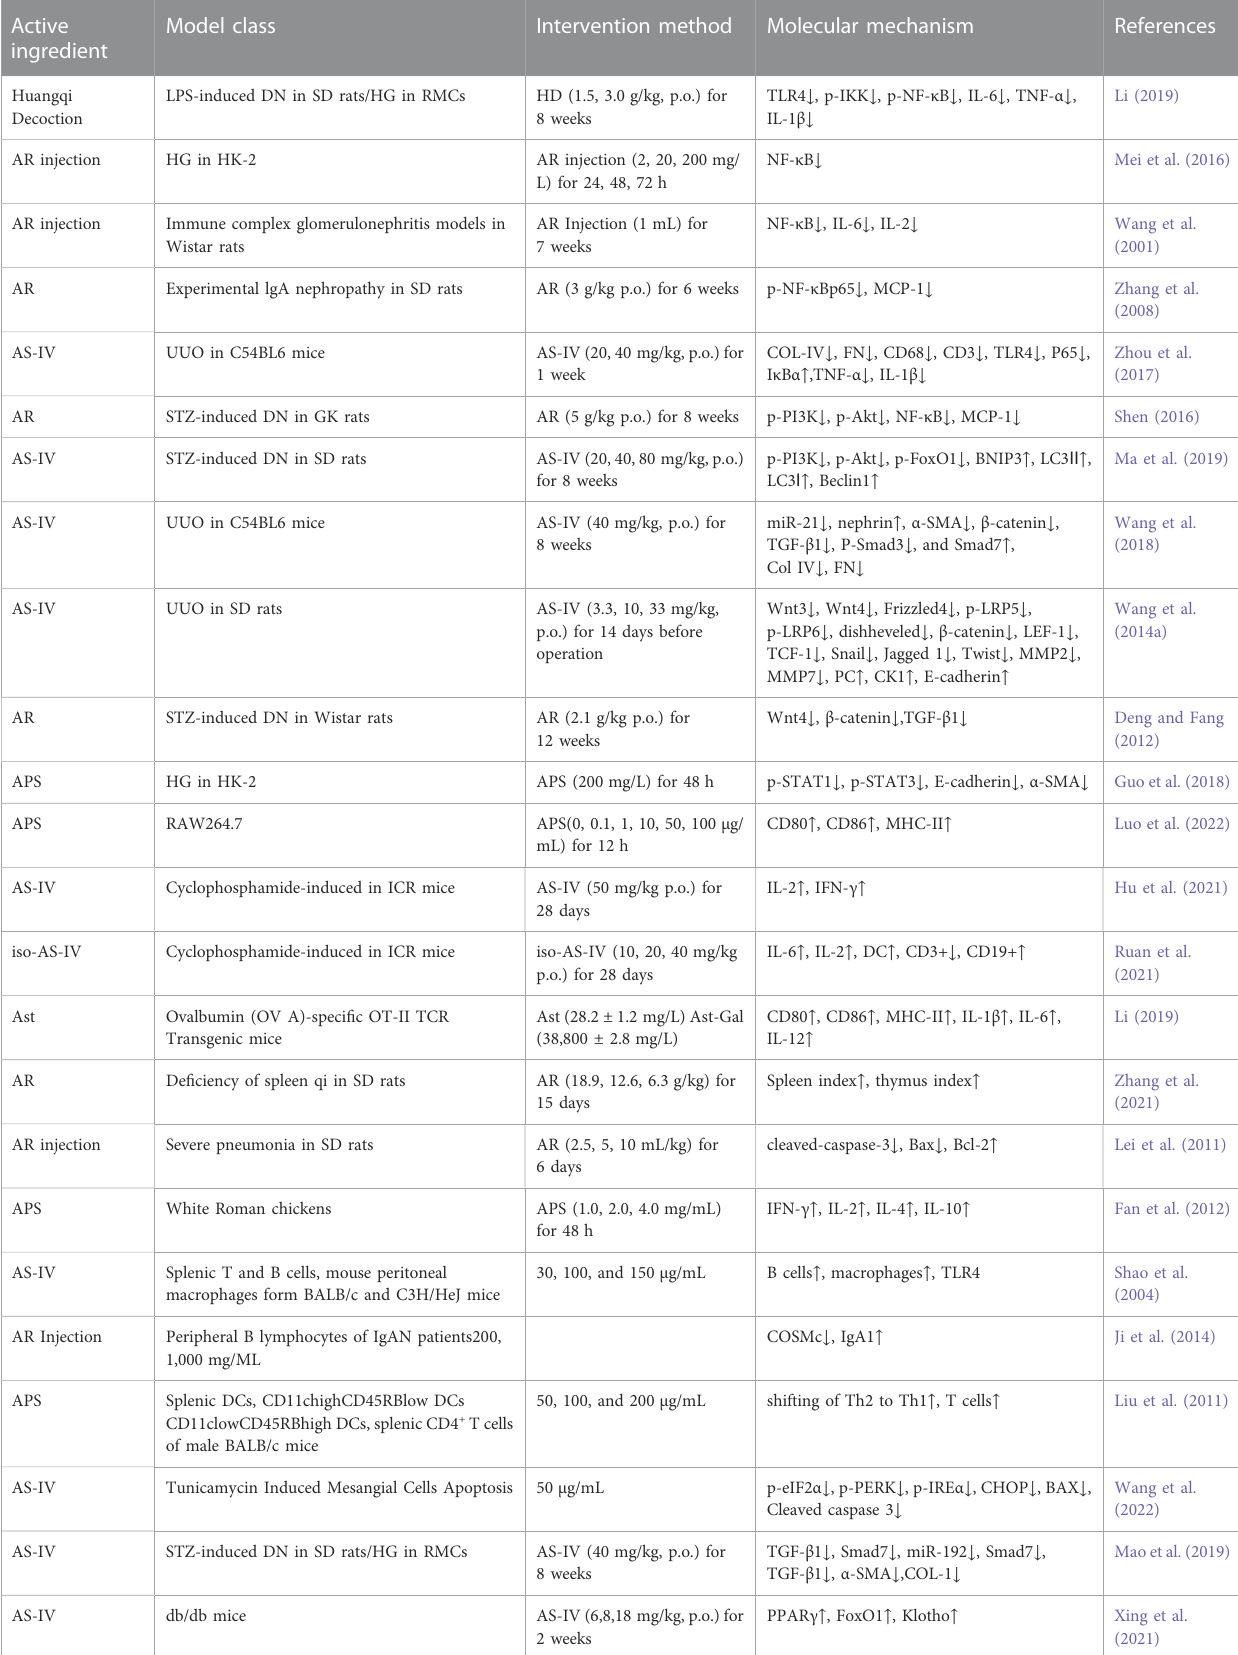
TABLE 3 The immune-modulatory and anti-in fl ammatory mechanisms of AR and its active constituents, and their impacts on intrinsic renal cells. Active